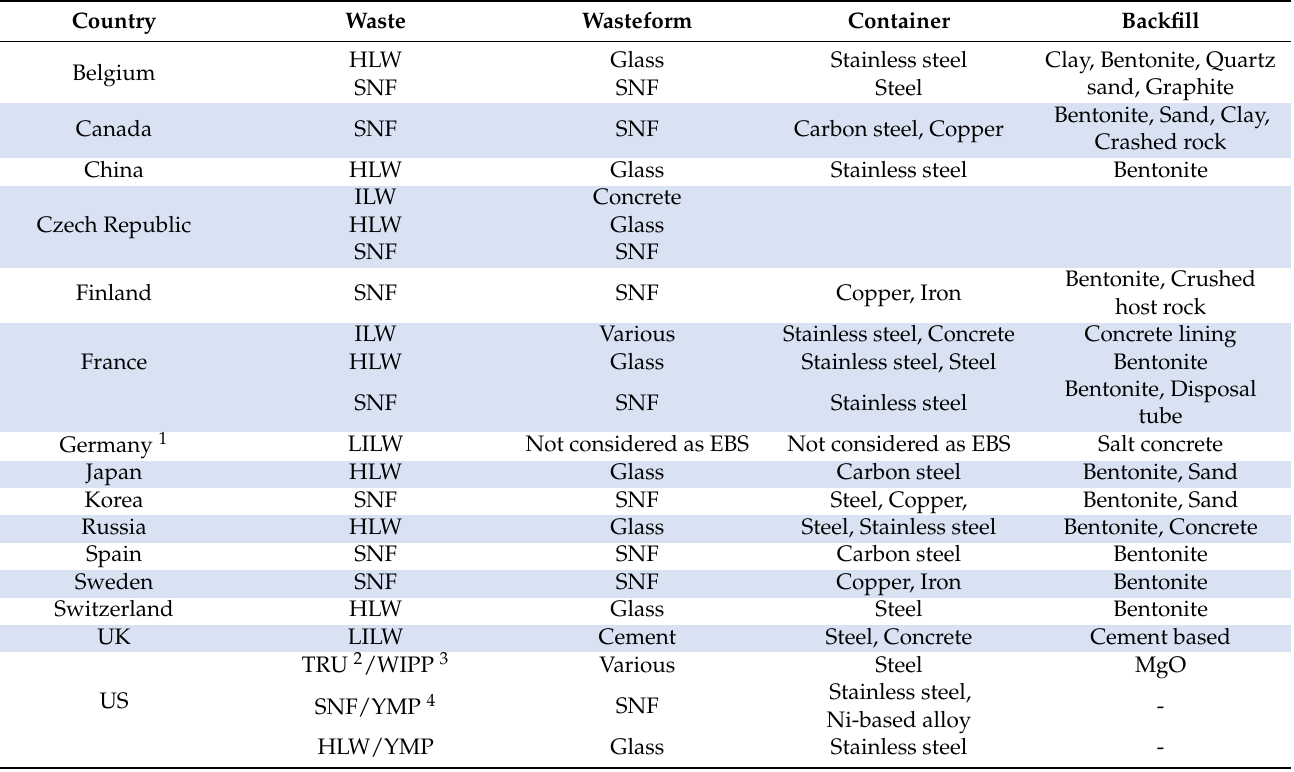
Table 4. Engineered barrier systems (EBS) components of actual or planned geological dis- posal/storage facilities.